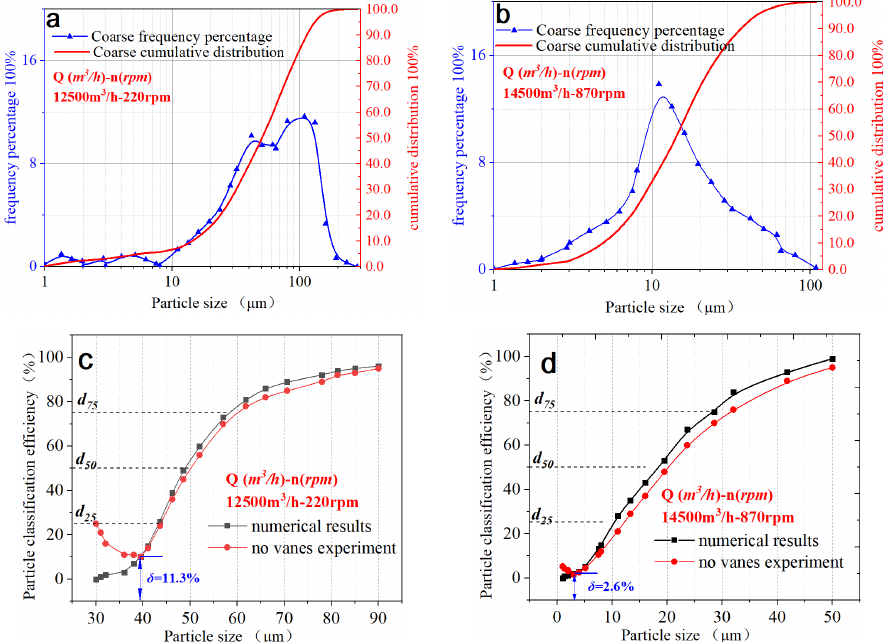
Figure 16. Experimental test results of two process parameters. ( a , b ) frequency percentage and cumulative distribution, ( c , d ) comparison of Tromp curves between the numerical simulation and experiment.